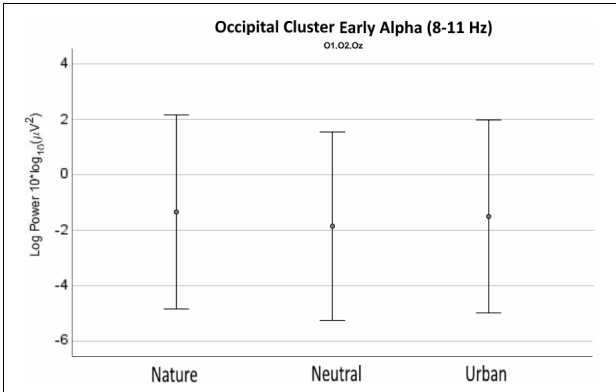
FIGURE 8 | Early alpha waves power density values as recorded (averaged) over the occipital cluster for neutral, nature, and urban experimental conditions. Error bars show standard deviations